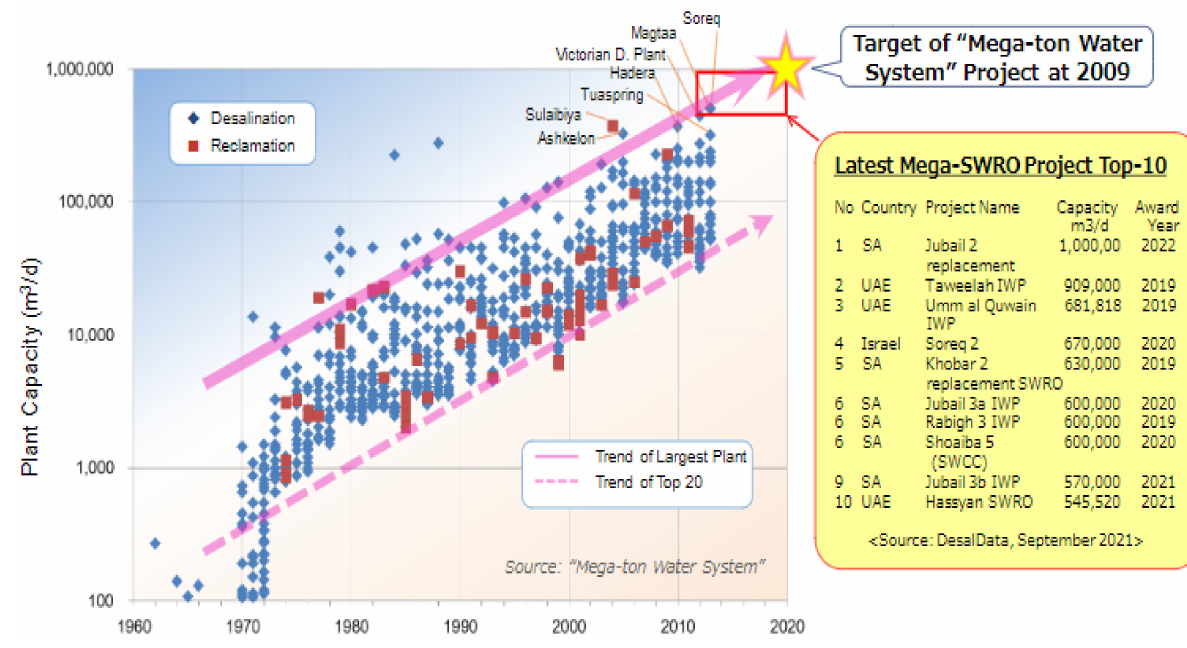
Figure 3. Global SWRO desalination plant capacity development